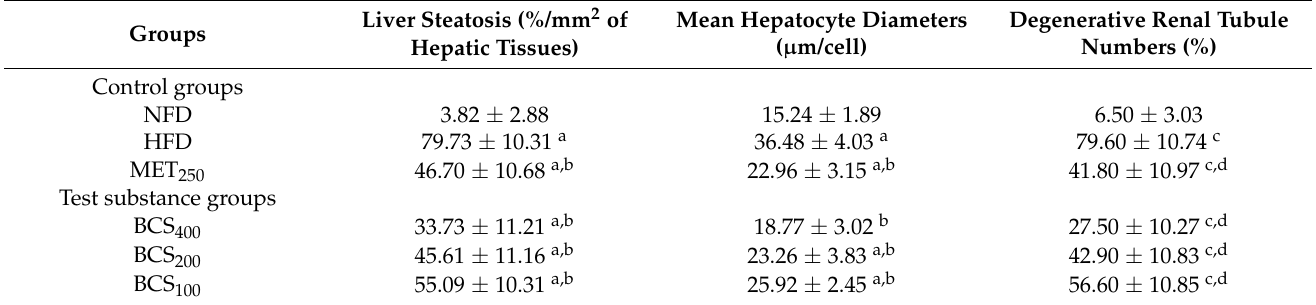
Table 7. Histopathology–histomorphometry of the kidney and liver in the HFD- and NFD-supplied